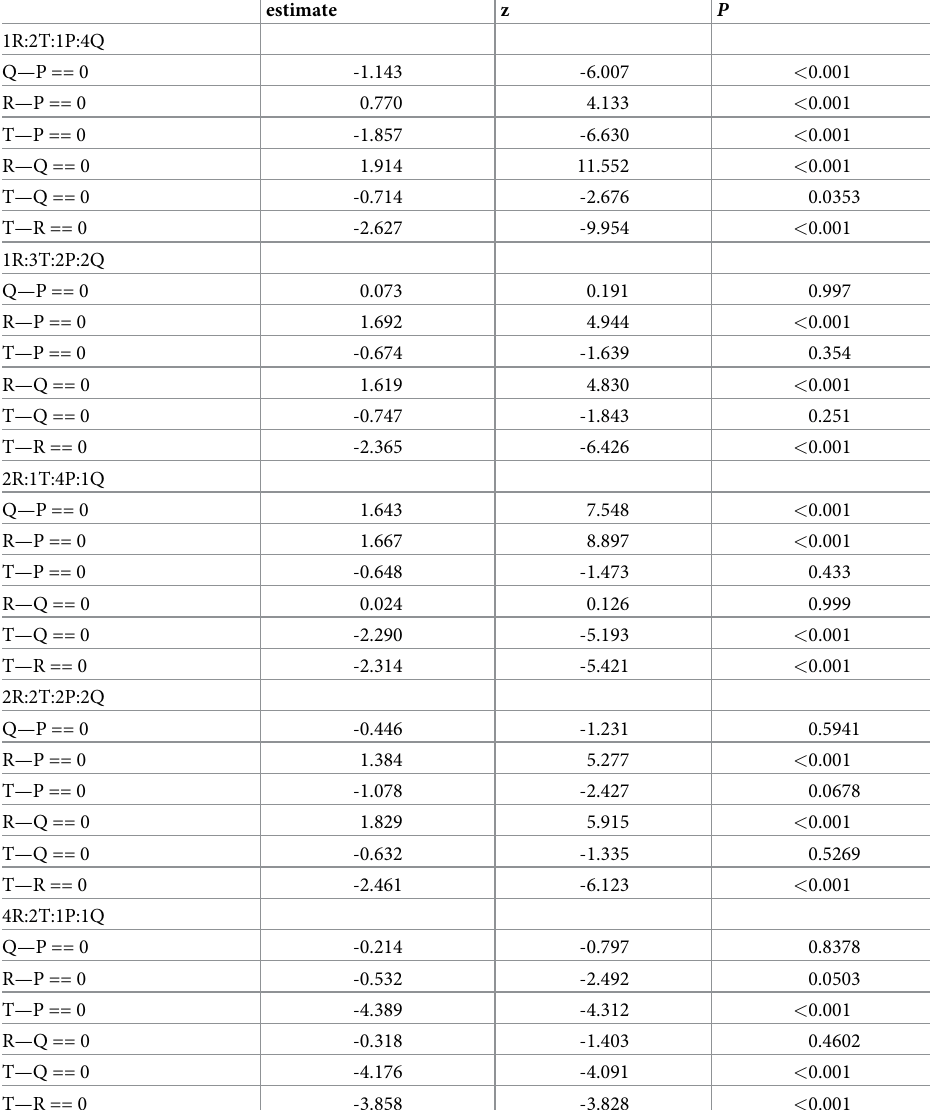
Table 1. Comparison of consumption of prey types within treatments. Each row shows the P -value for the null hypothesis that there is no difference in consumption between the prey species. Results come from GLMM’s testing the likelihood of individual prey snails within treatments being consumed, based on species. Multiple comparisons were Tukey corrected within treatment. Prey species are Ramshorn snails (R), Malaysian Trumpet snails (T), Pond snails (P), and Quilted melania (Q) snails.